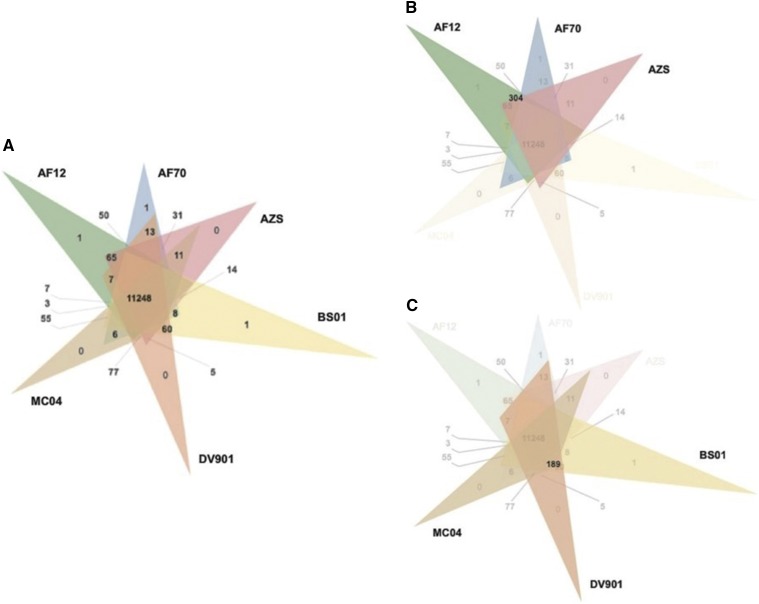
Venn diagrams representing the clustering results from Orthofinder to illustrate the number of proteins unique to and orthologous in each genome. (A) The number of clusters containing proteins unique to and orthologous in all six genomes; (B) the number of clusters containing proteins from only S morphotype genomes and (C) only L morphotype genomes.